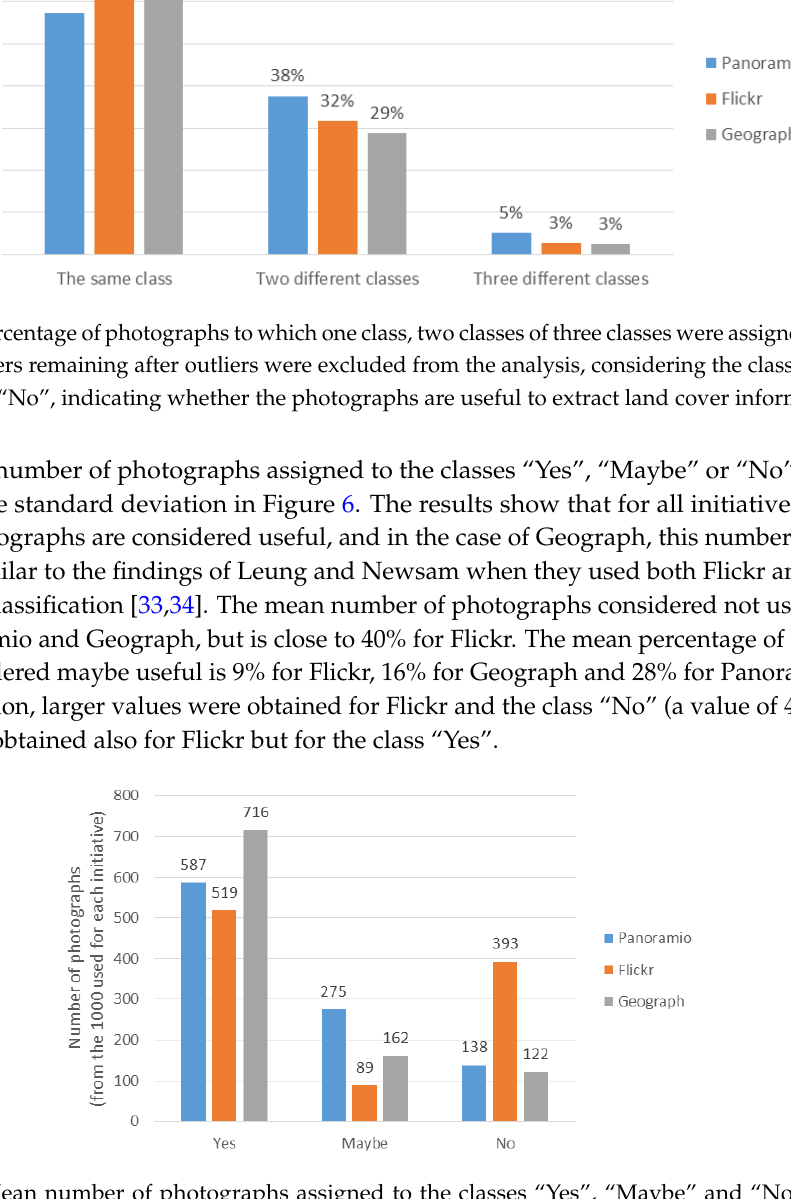
Figure 3. Number of photographs assigned to each class “Yes”, “Maybe” or “No” by the seven